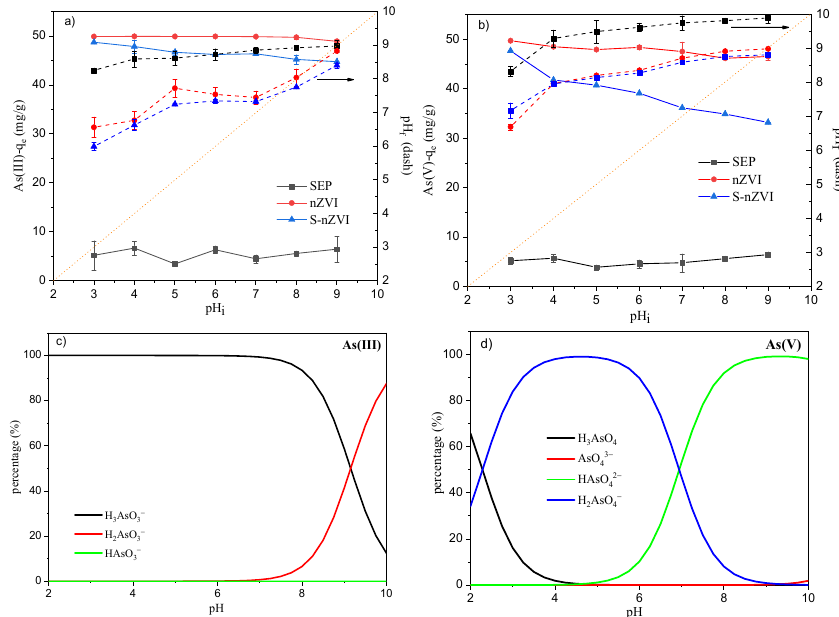
Figure 2. Influence of initial pH on ( a ) As(III) and ( b ) As(V) adsorption capacity (pH i and pH f indicate initial pH before S-nZVI dosing and final pH after adsorption, respectively); the distribution of different ( c ) As(III) and ( d ) As(V) species in aqueous solution calculated with Visual MINTEQ.